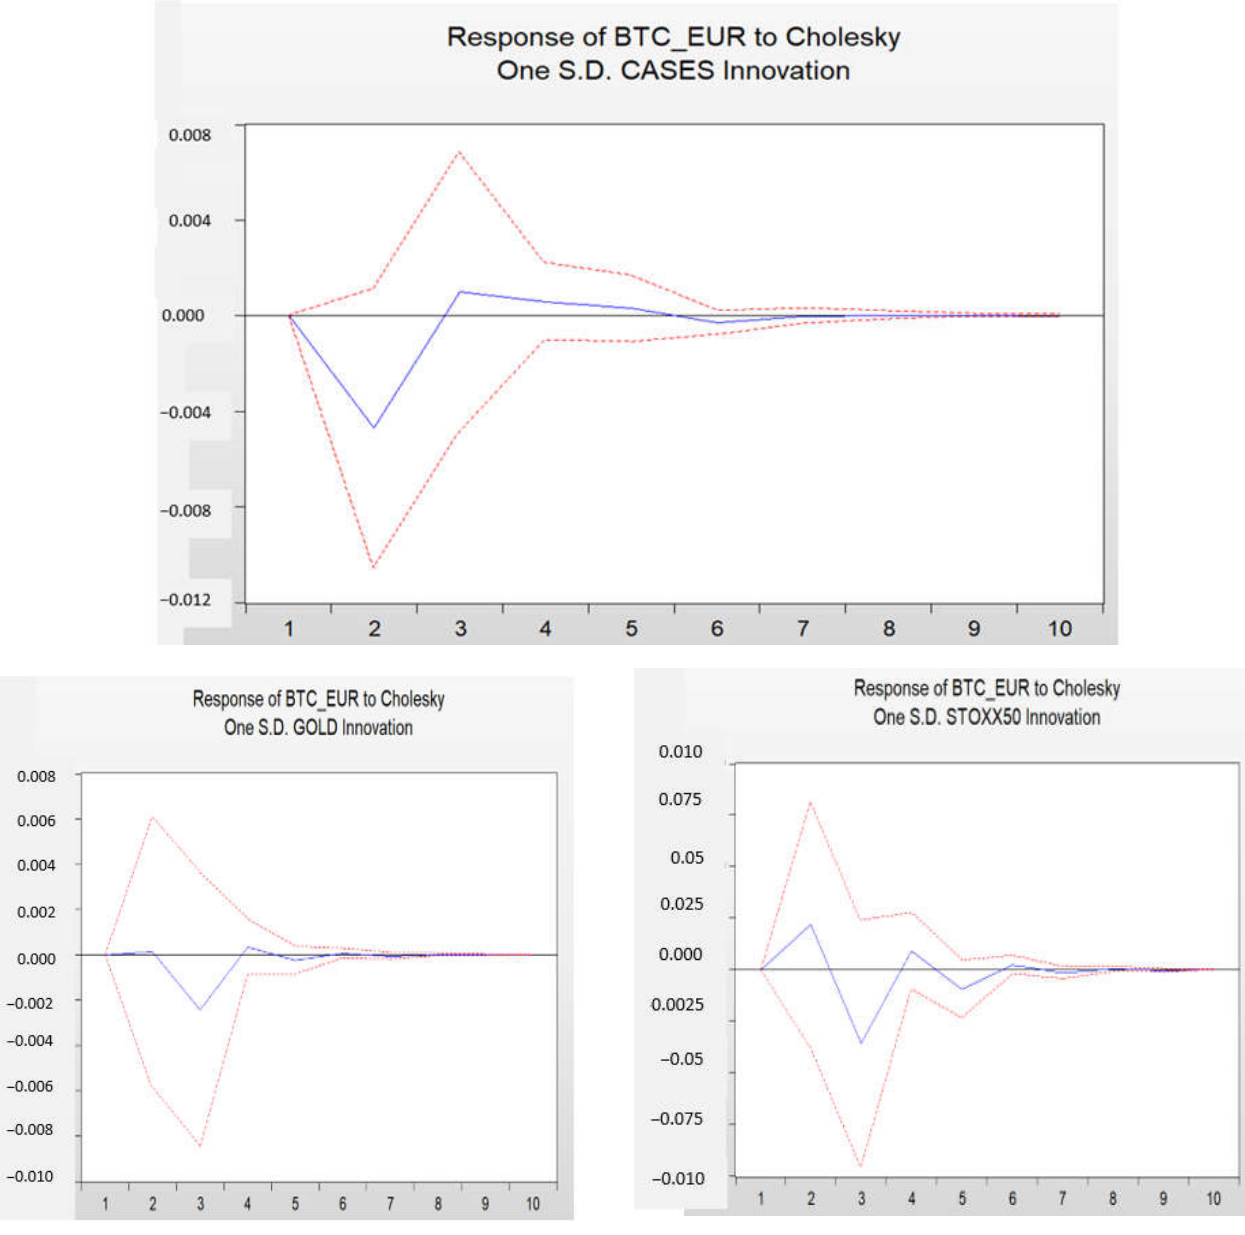
Figure 5. Impulse response of BTC/EUR. Notes: The red line depicts the confidence interval, while the blue line depicts the response of bitcoin to Cholesky. One S.D innovation of each variable.